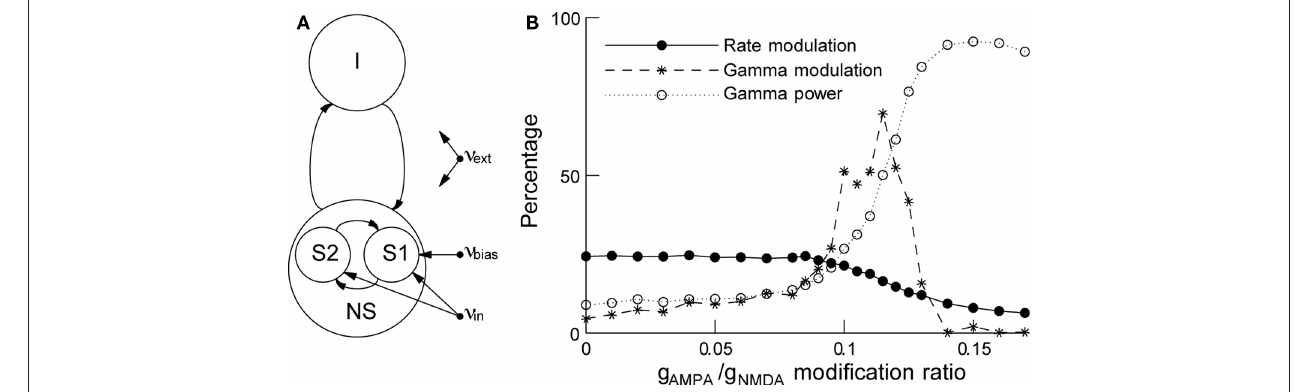
also an input ( ν ) that simulates the spontaneous activity in the surrounding ext cerebral cortex. (B) Rate modulation (solid curve) and gamma modulation (dashed curve) as a function of the modification ratio g / g for excitatory synaptic AMPA NMDA conductances. Increasing this ratio increases rhythmic gamma band power (dotted curve), decreases the rate modulation monotonically while gamma modulation peaks around ). All neurons get bias